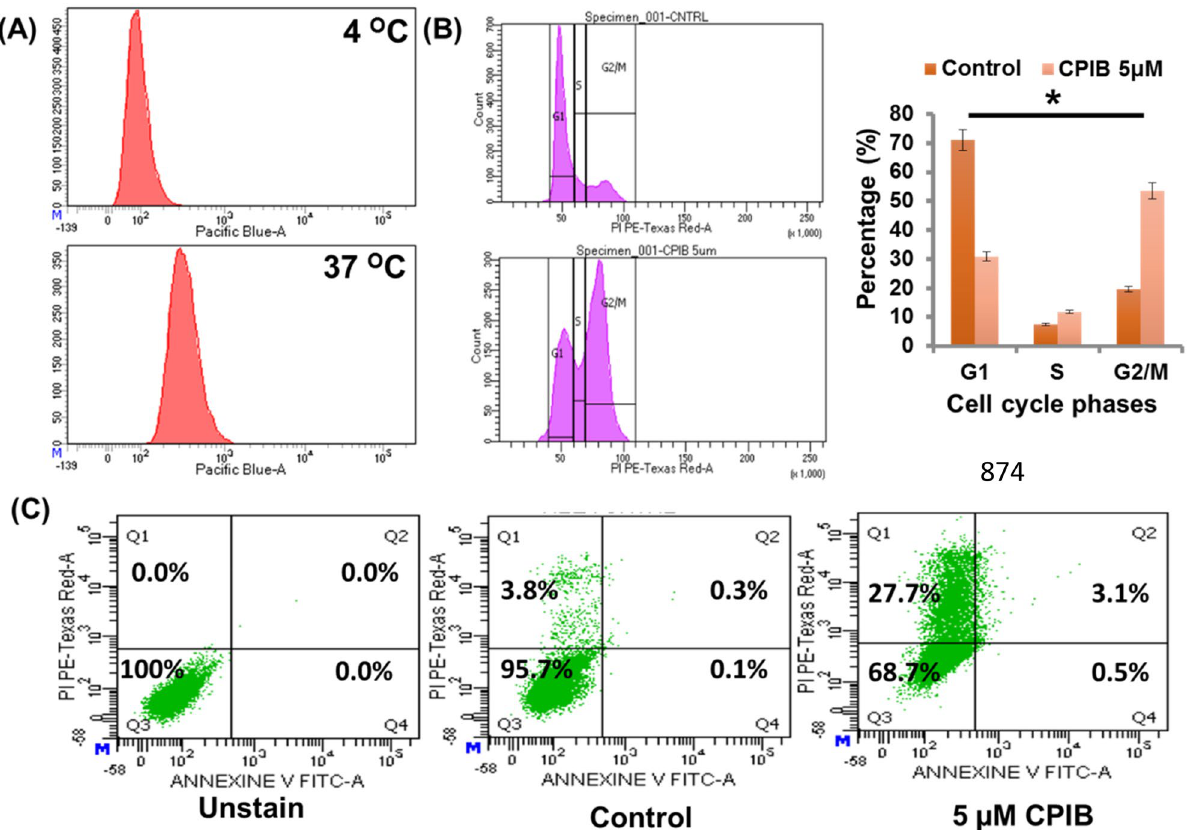
Figure 7. Flow cytometric assays confers apoptotic death by CPIB ( A ) Flow cytometric cell cycle analysis showing increased uptake at 37 °C compared to lower temperature at 4 °C. ( B ) Cell cycle analysis using flow cytometry after treating with CPIB (5 µM) showing arrest of cell cycle at G2/M phase. ( C ) Cellular death pathway (Apoptosis) using annexin-V and Propidium Iodide (PI) showing rapid increase in apoptotic